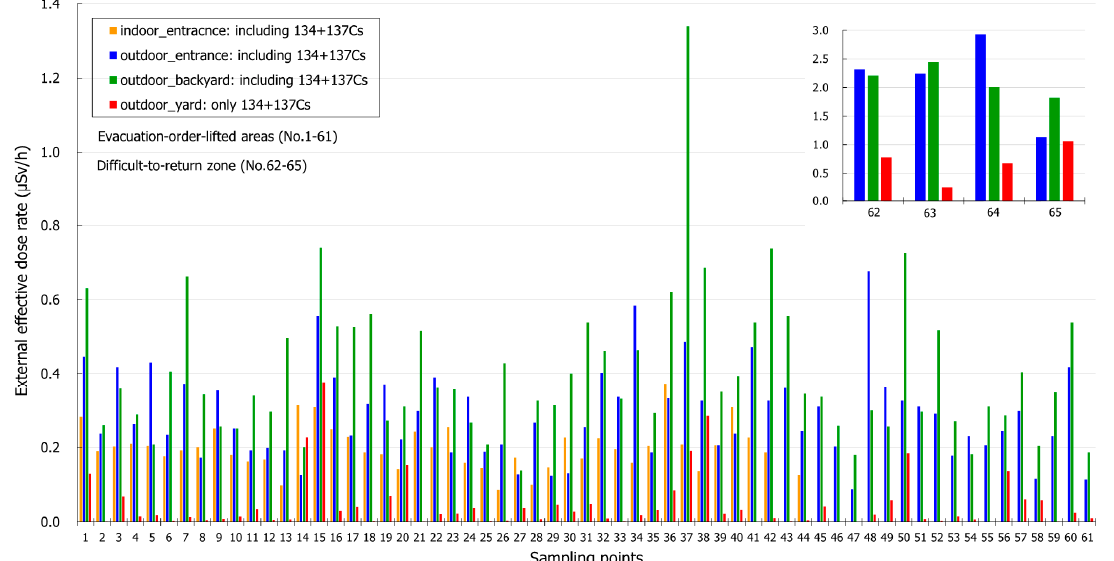
Figure 3. External exposure doses immediately after the cancellation of restriction in Tomioka Town. The effective external doses in residents living space within housing sites during September to October in 2017. Yellow, blue and green squares show the natural dose rates including radiocesium. Red square shows the external effective dose rates from soil samples (only radiocesium).